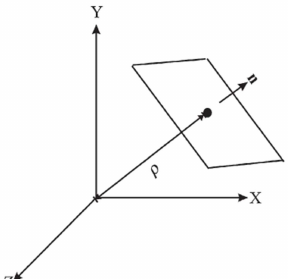
Figure 3. Parameters of the plane in the parameterization proposed in Van den Heuvel (1999): normal n and distance from the origin ρ